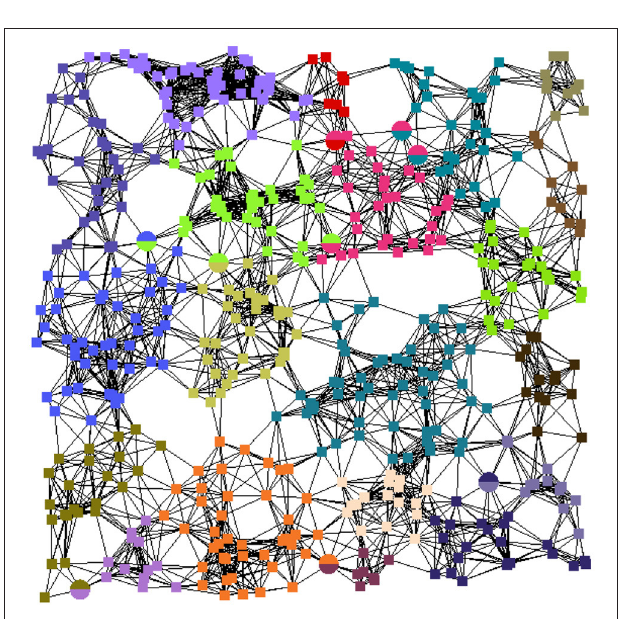
FIGURE 6 | Communities found in a large scale topology with 250 nodes.